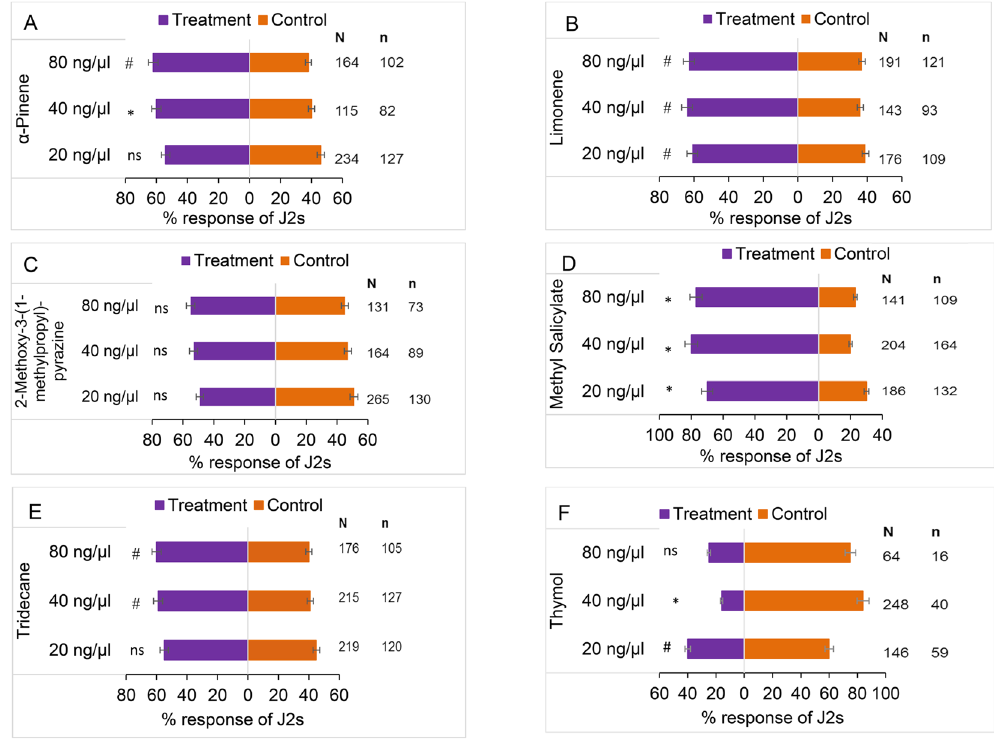
Figure 2. Differential responses of Meloidogyne incognita to individual synthetic compounds identified in pepper root volatiles. Response of Meloidogyne incognita infective juveniles (J2s) to different doses of ( A ) α -pinene compared to a control (moist sand). ( B ) Limonene compared to a control ( C ) 2-methoxy-3-(1- methylpropyl)pyrazine compared to a control ( D ) methyl salicylate compared to a control ( E ) tridecane compared to a control ( F ) thymol compared to a control. N corresponds to the total number of responding J2 while n is the number of J2 corresponding to a given treatment. The level of significance in indicated by * P < 0.0001, # P < 0.05 and ns = not significant at P =